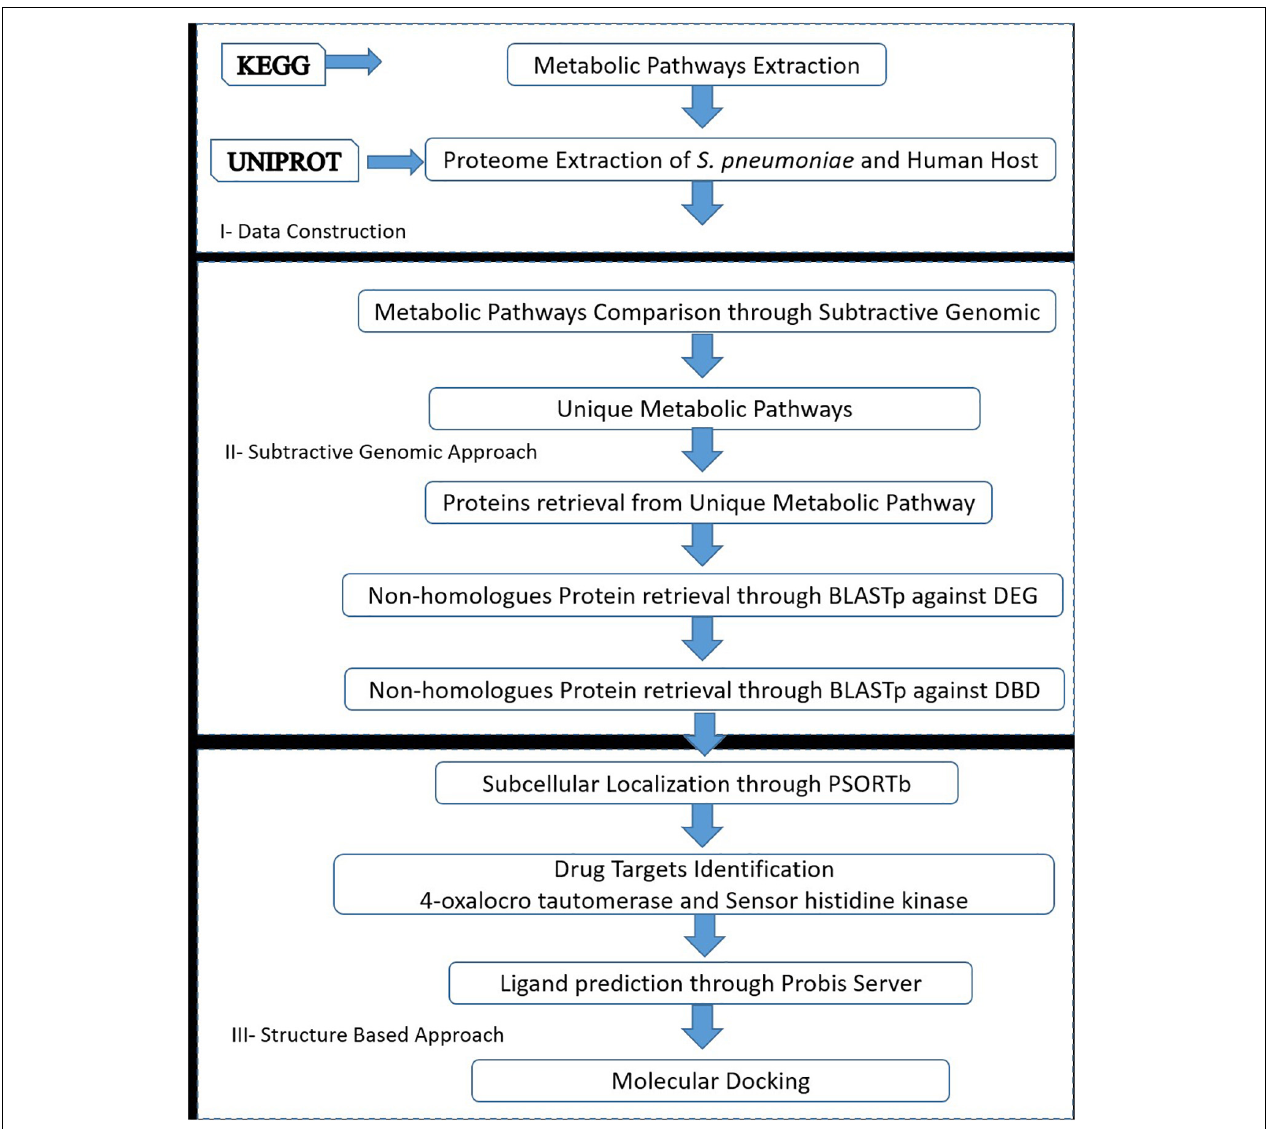
FIGURE 1 | Flow chart: A general sketch of the current study integrated with the use of various computational approaches and tools to identify potential drug targets candidates.